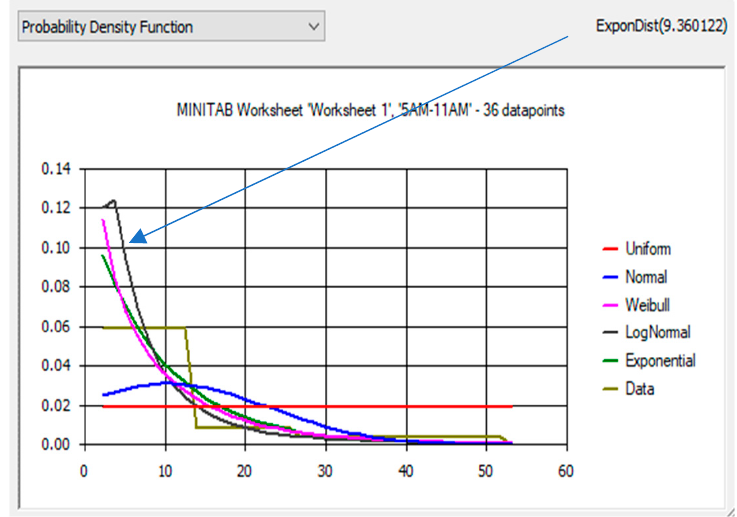
Figure 13. The solution of service span time by proposed methodology aided by AIoT management.